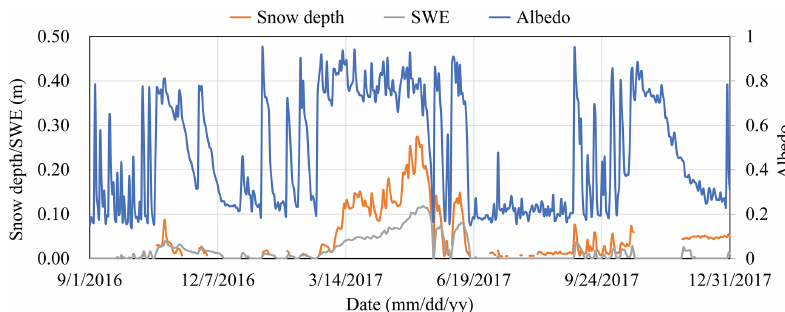
Figure B7. Time series of the snow depth, snow water equivalent (SWE), and albedo (Yakou station).